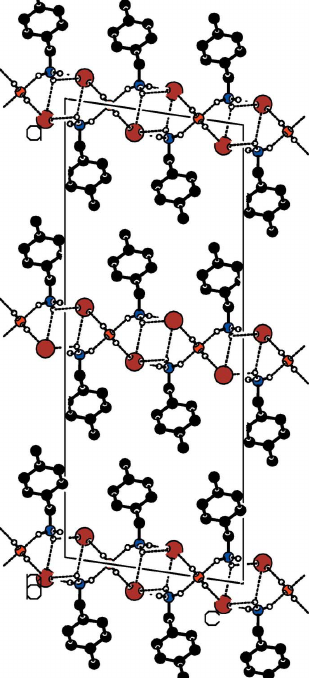
Figure 2 The crystal structure of (I), viewed down the b axis, showing the formation of hydrogen bonding. Dashed lines indicate hydrogen bonds. H atoms not involved in hydrogen bonding have been omitted.